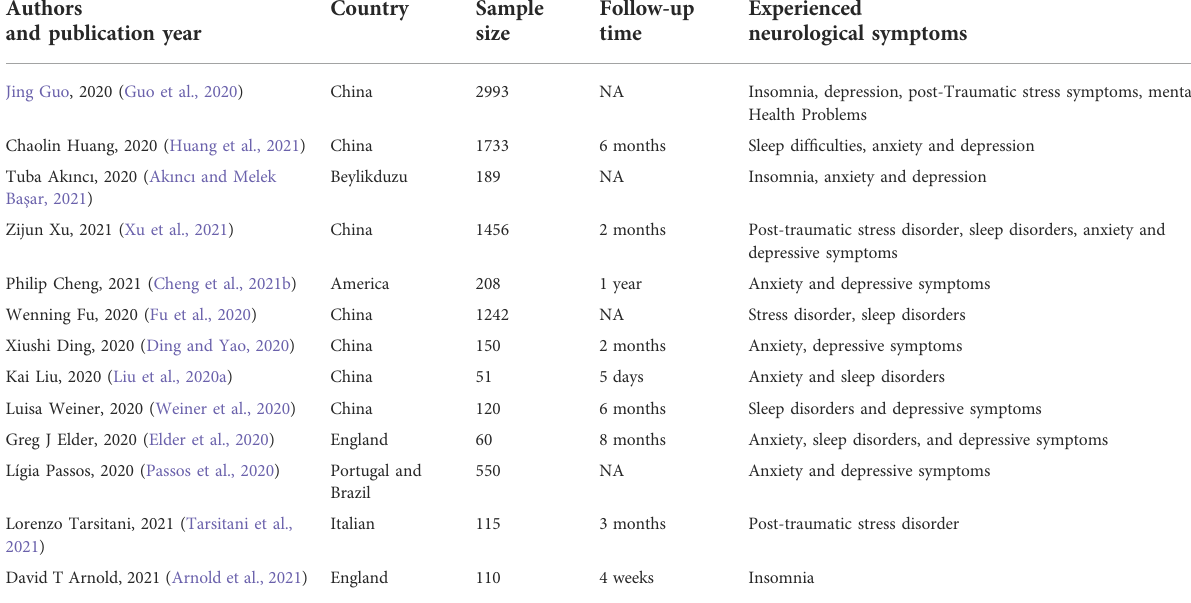
TABLE 1 Summary of the different neurological symptoms induced by the